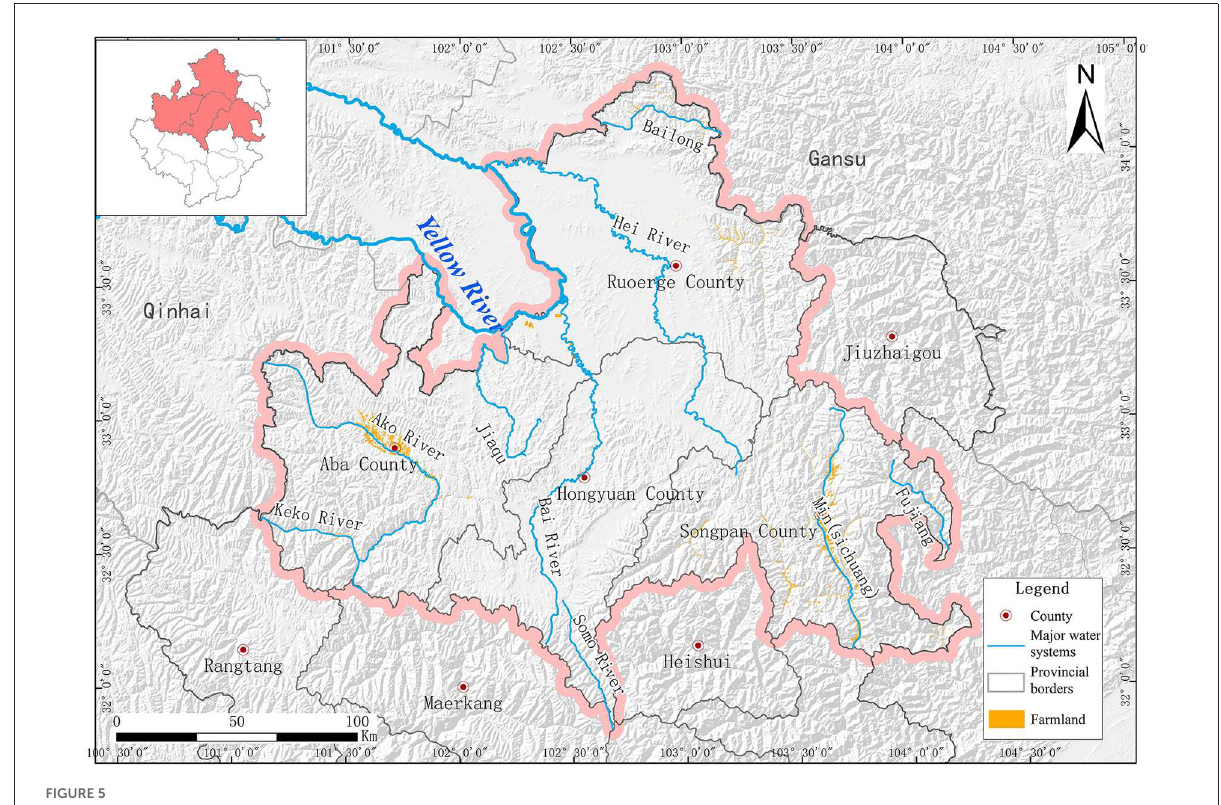
FIGURE5 Farmland ecosystem distribution in the study